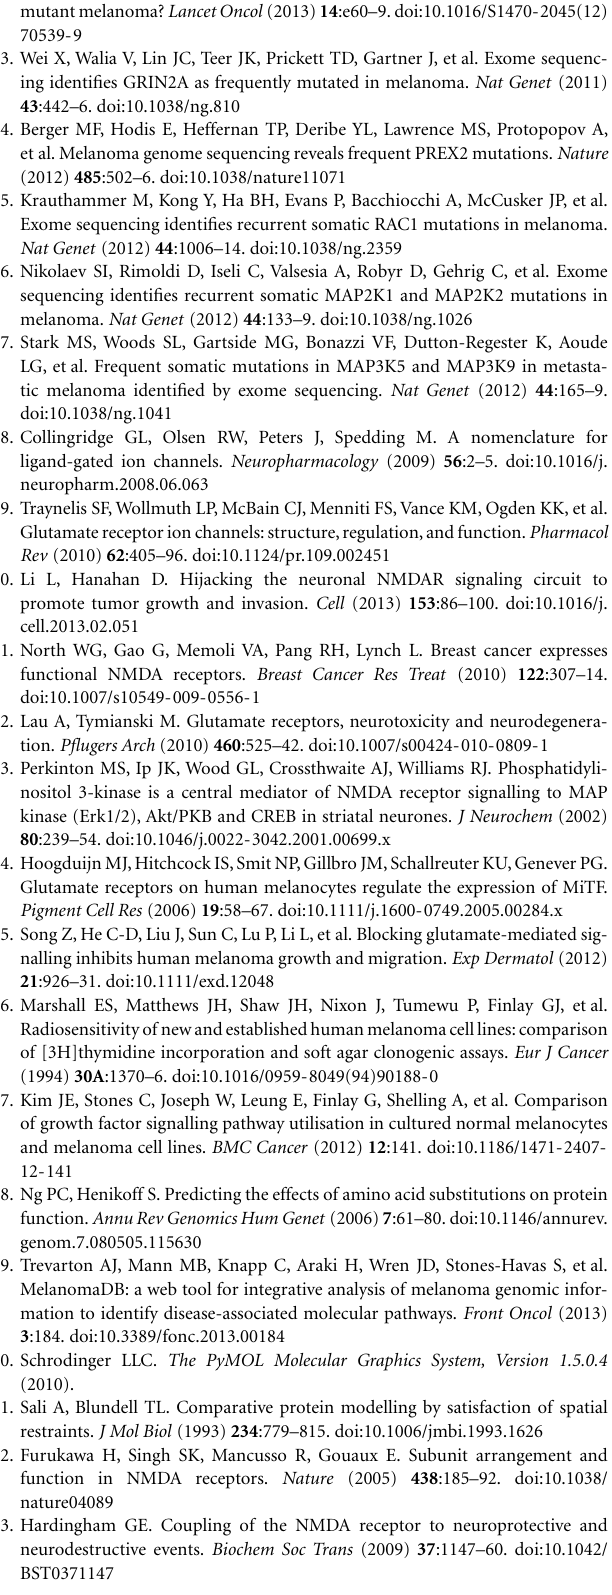
Figure S1 | Summary of disease progression events for patients with no, synonymous, and non-synonymous mutations in GRIN2A . Data points for individual patients are shown; horizontal lines mark median values in each group. Levels of statistical difference between groups are shown. *Disease progression data for one patient with non-mutated GRIN2A were not available. Table S1 | Summary of NZM cell lines tested in this study, together with their mutation status and systemic therapy received by patients prior to cell line establishment